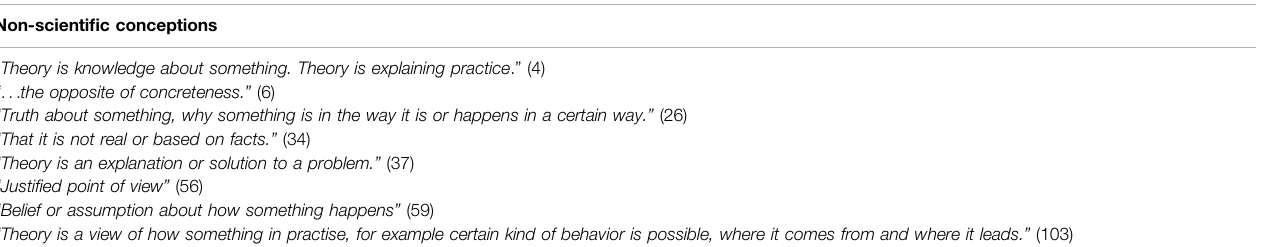
TABLE 1 | Examples of students ’ answers in the category non-scienti fi c conceptions . Non-scienti fi c